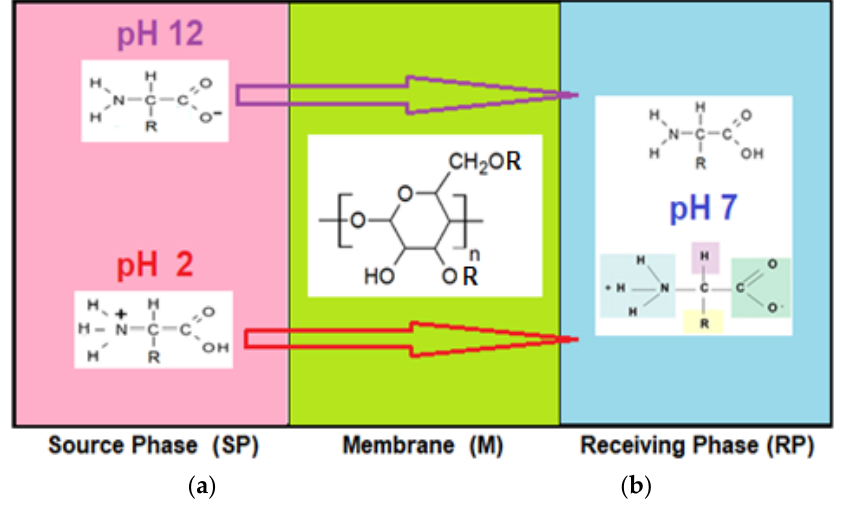
Figure 14. The transport mechanism of the amino acids at: ( a ) pH = 2 and pH = 12 for the source phase (SP); and ( b ) pH = 7 (pure water) in the receiving phase (RP).